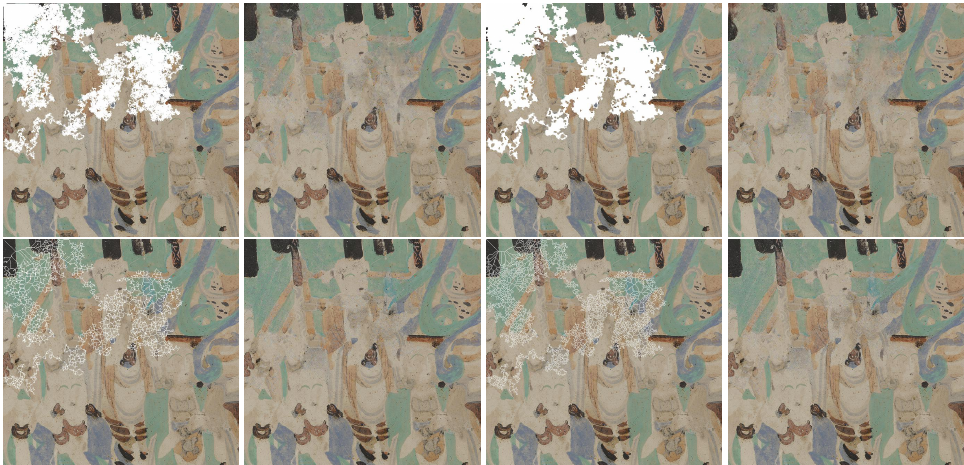
Figure 8. Pairs of inpainting results for morphological variations of random walk masks with different coverage of the same scene (ground-truth is Figure 6b). The colors are well preserved in the restored version. In the second pair (top third and fourth images), where dilated random walk deterioration is used, we can notice more blurriness.